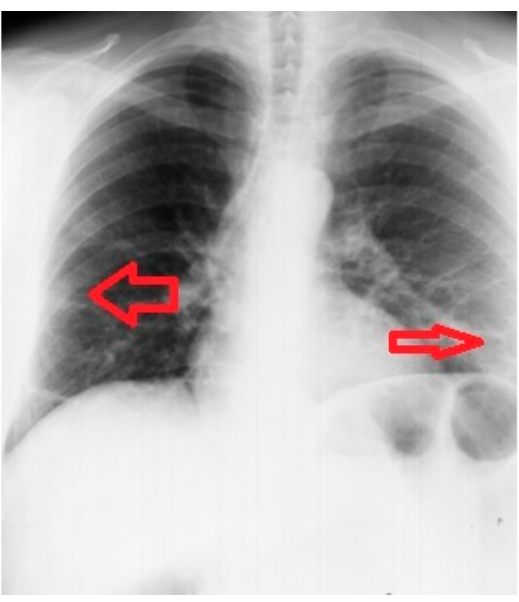
Figure A1. Chest X-ray at admission (H-Day 1) Accentuated interstitial pattern, inhomogeneous subpleural opacities in the lower half basal bilaterally.